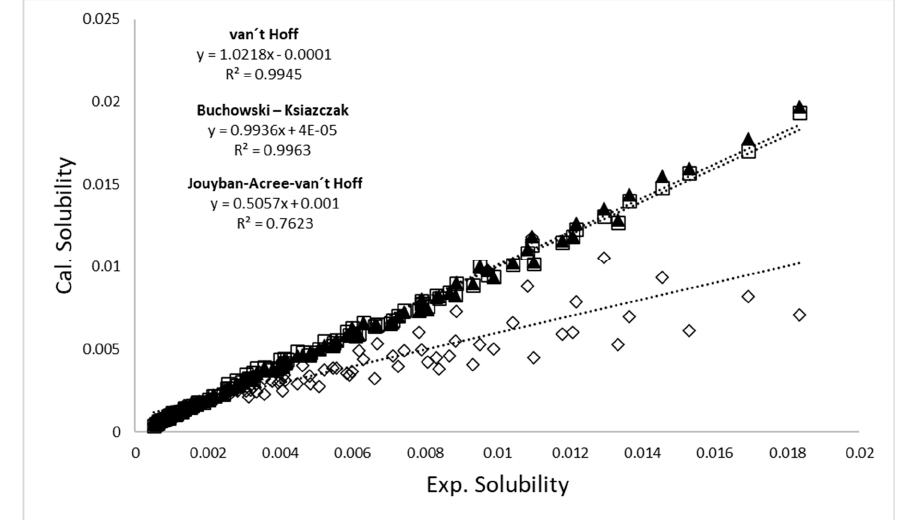
Figure 3. Plot of calculated versus experimental solubility data of amygdalin in {ethanol (1) + water (2)} cosolvent mixtures ( ▲ = van’t Ho ff , □ = Buchowski–Ksiazczak, and ◊ = Jouyban–Acree–van’t Hoff).